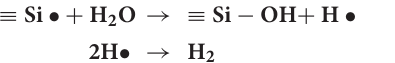
TABLE 4 | The hydrocarbons detected during grinding. Glacier